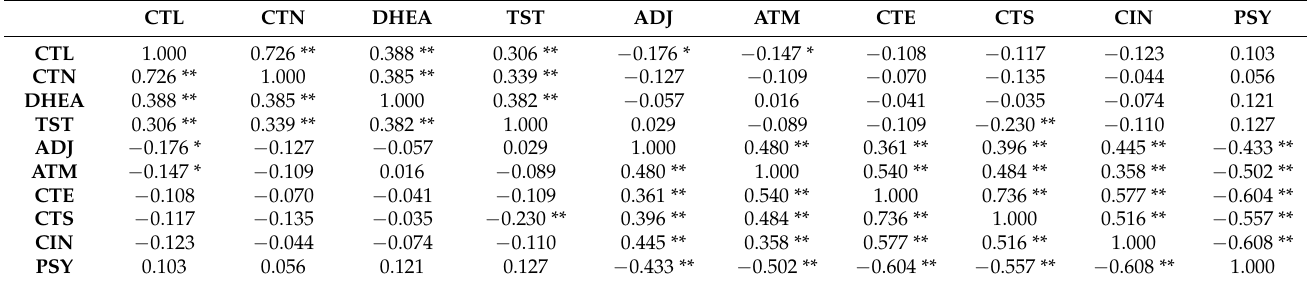
Table 4. The relationship between hair steroid hormone levels and military training social environmental